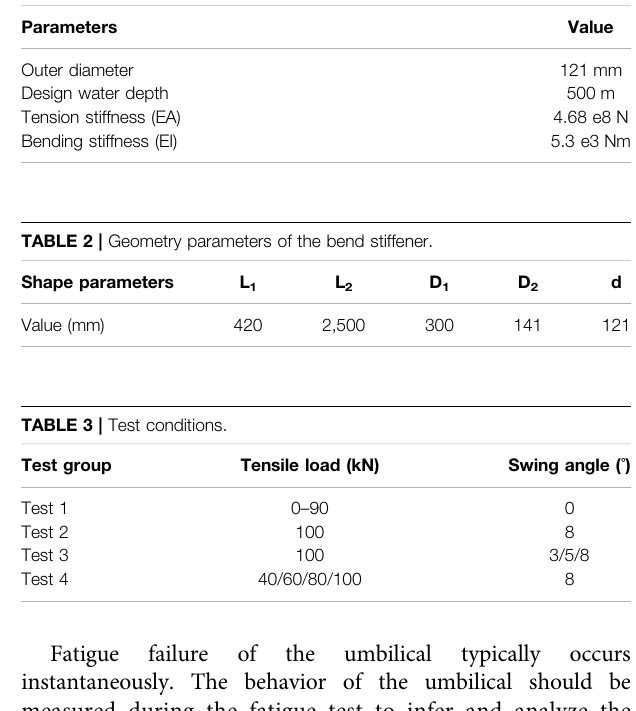
TABLE 1 | Key parameters of the umbilical.